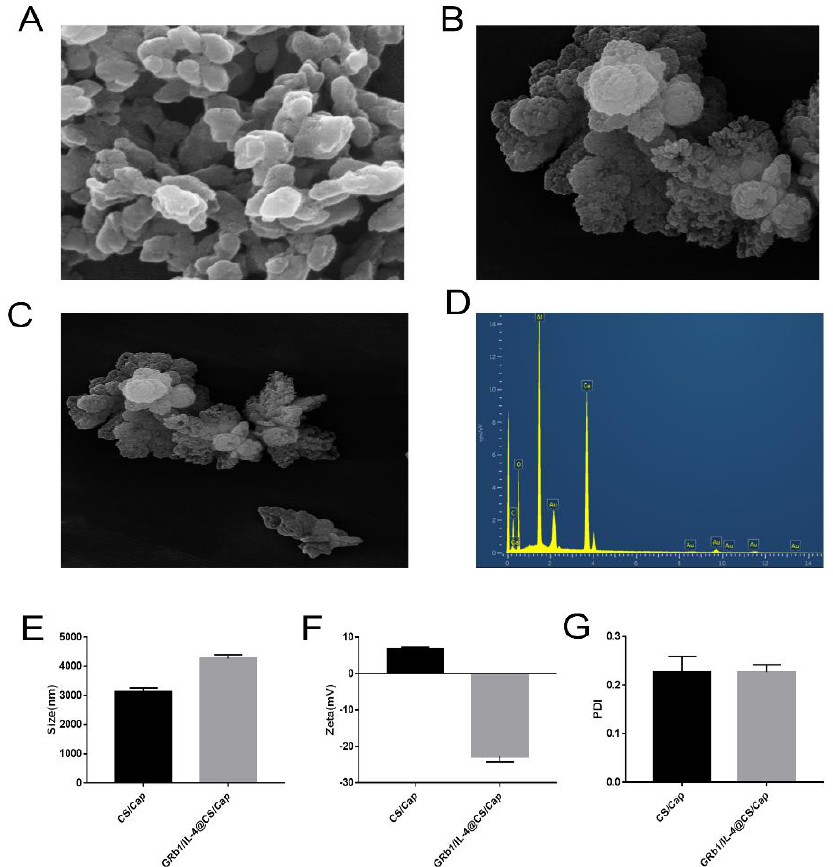
Figure 1. Characterization of CS/CaP and GRb1/IL-4@CS/CaP microparticles. ( A – C ) SEM of CS/CaP and GRb1/IL-4@CS/CaP. Scar bar = 5 µ m. ( D ) Elemental mapping images. ( E , F ) Particle size and Zeta-potential of CS/CaP and GRb1/IL-4@CS/CaP. ( G ) PDI of CS/CaP and GRb1/IL-4@CS/CaP.